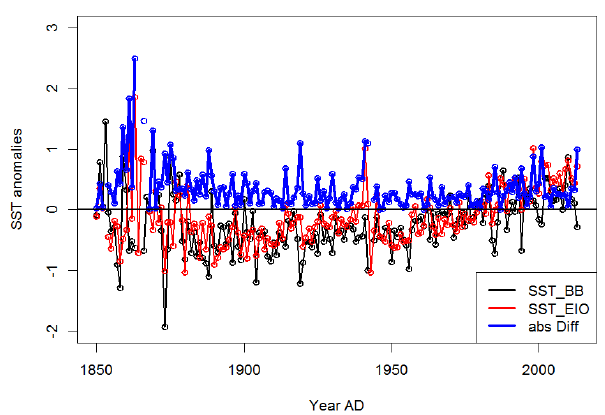
Figure 7. Sea surface temperature anomalies in different regions of the Indian Ocean: Bay of Bengal–North Indian ocean (SST BB: equatorial and northern Indian Ocean (2.5 ◦ N–2.5 ◦ S, 52.5– 112.5 ◦ E; 22.5—27.5 ◦ N, 52.5–112.5 ◦ E) and equatorial Indian Ocean (SST EIO: 2.5 ◦ N–2.5 ◦ S, 52.5–112.5 ◦ E) (Rayner et al., 2006). Difference between the two time series is marked with a blue